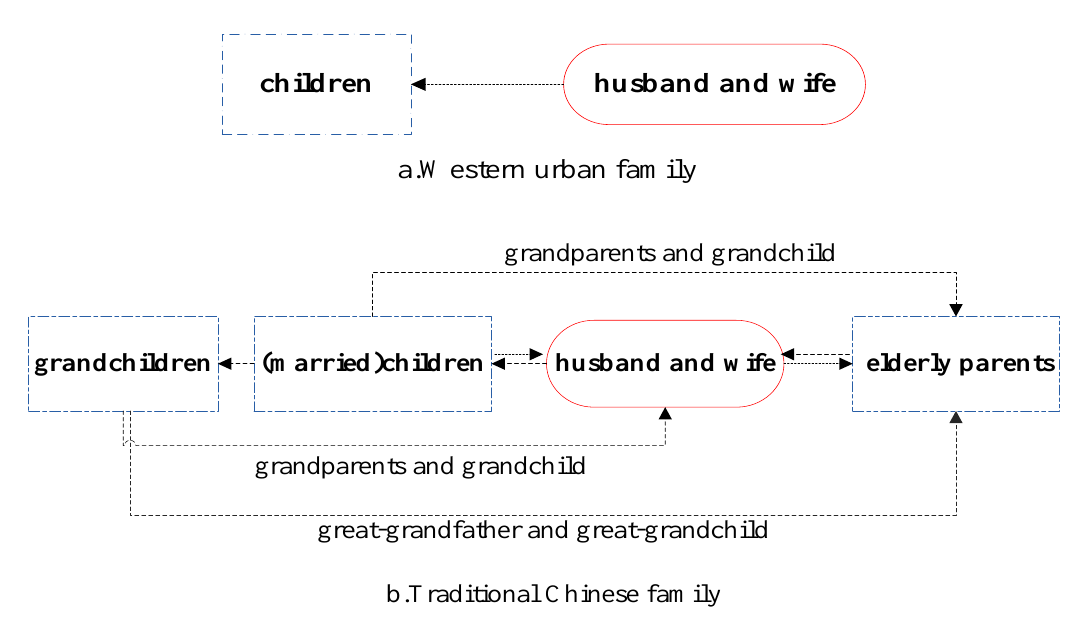
Figure 1. Intergenerational relationships in Chinese and Western families.